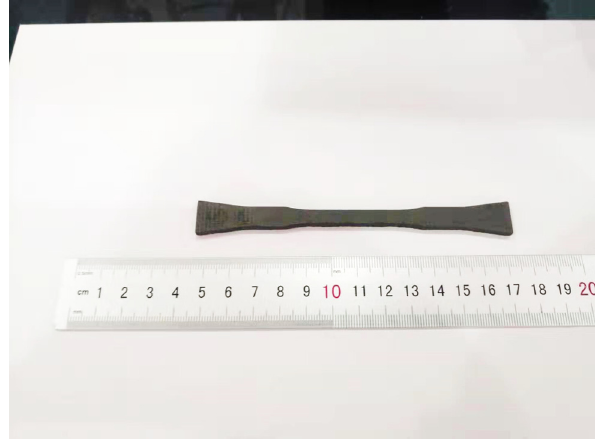
Figure 3: Photo of the dog - bone specimen for tensile test of 2D CVI - SiC/SiC composite at 900°C in air atmosphere.